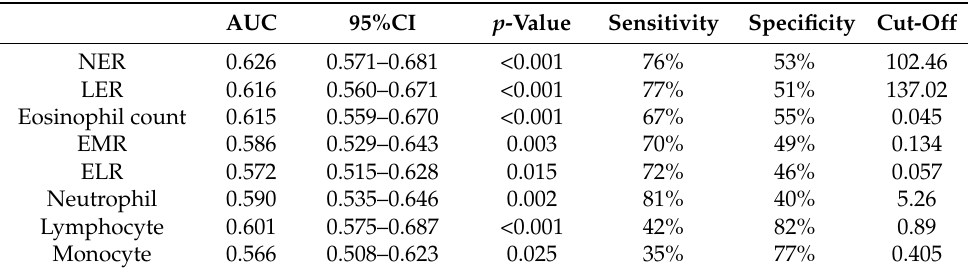
Table 3. ROC curve analysis demonstrating the cut-off values for eosinophil indices to predict the 6-moths MACE.